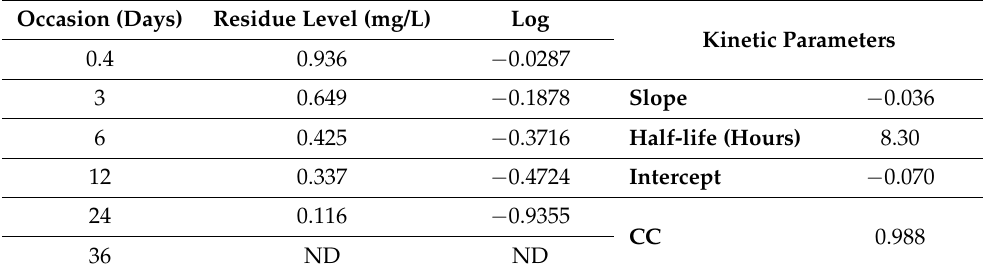
Figure 11. Representative photocatalytic 0th hour mancozeb standard, control and sample chro- matograms. Table 3. The photocatalytic summarized results of kinetic